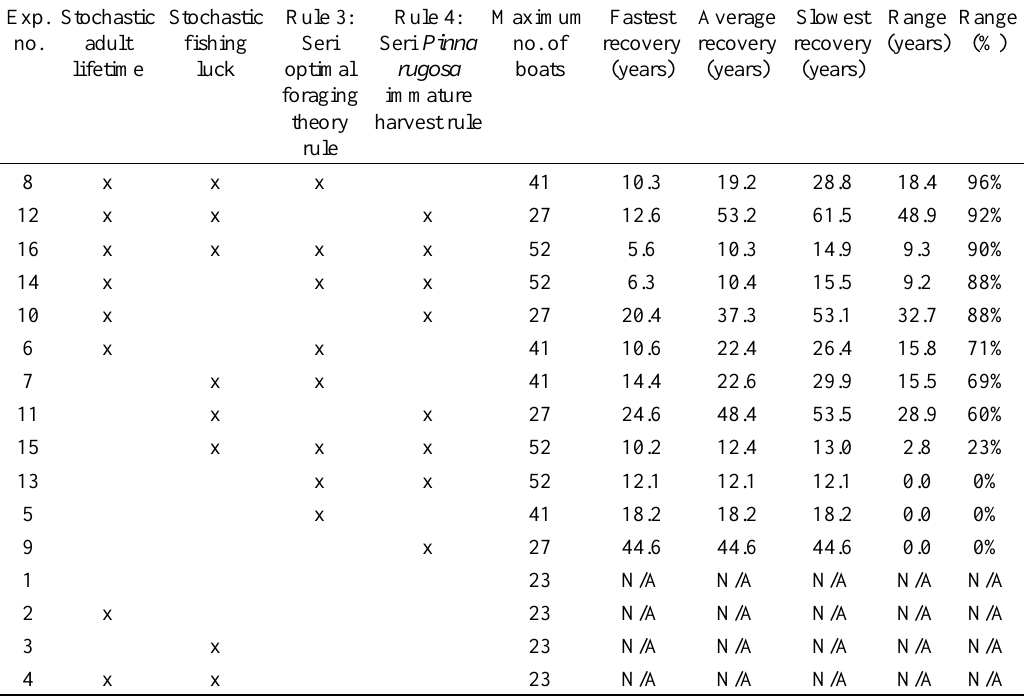
Table 4. Recovery experiments, sorted by range between fastest and slowest recovery in different runs (as percent of recovery period). The letter x indicates which stochastic variables and/or institutional rules are active in each experiment. Range is the difference between the fastest and slowest recovery time.